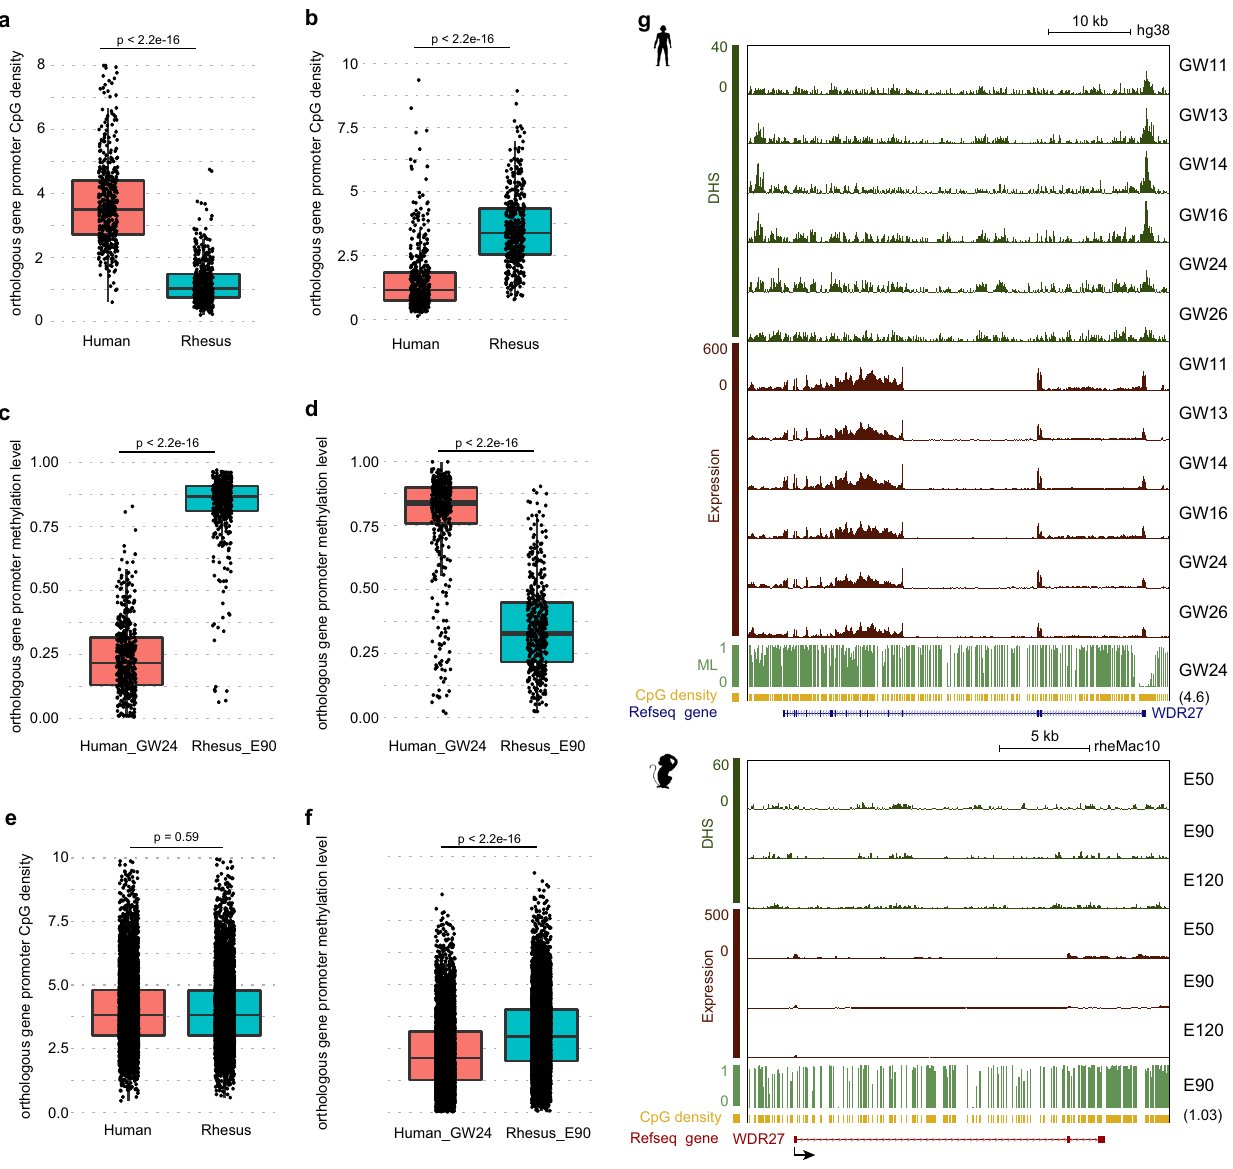
Fig. 5 The association between CpG densities and species-speci fi c DHSs. a Box and jitter plots comparing promoter CpG densities of orthologous genes, whose promoters are speci fi cally open in the human PFC ( n = 470 genes). Boxes and whiskers represent the 25th/75th percentiles and 1.5 ´ the interquartile range, respectively. The center in the boxplot represents the medium value. Student ’ s t test with a two-sided model was used in this fi gure. b Box and jitter plots comparing promoter CpG densities of orthologous genes, whose promoters are speci fi cally open in rhesus PFC ( n = 430 genes). Boxes and whiskers represent the 25th/75th percentiles and 1.5 ´ the interquartile range, respectively. The center in the boxplot represents the medium value. Student ’ s t test with a two-sided model was used in this fi gure. c Box plots showing DNA methylation levels of orthologous genes, whose promoters are speci fi cally open in humans ( n = 470 genes), at the human GW24 stage and the E90 stage in rhesus monkeys, respectively. Boxes and whiskers represent the 25th/75th percentiles and 1.5 ´ the interquartile range, respectively. The center in the boxplot represents medium value. Student ’ s t test with a two-sided model was used in this fi gure. d Box plots showing DNA methylation levels of orthologous genes, whose promoters are speci fi cally open in rhesus ( n = 430 genes), at rhesus E90 stage and human GW24 stage, respectively. Boxes and whiskers represent the 25th/75th percentiles and 1.5 ´ the interquartile range, respectively. The center in the boxplot represents the medium value. Student ’ s t test with two-sided model was used in this fi gure. e Box plots comparing promoter CpG densities of orthologous genes whose promoters are open in both human and rhesus ( n = 6683 genes) PFC. Boxes and whiskers represent the 25th/75th percentiles and 1.5 ´ the interquartile range, respectively. The center in the boxplot represents the medium value. Student ’ s t test with a two-sided model was used in this fi gure. f Box plots showing DNA methylation levels of orthologous genes whose promoters are conserved open in humans and rhesus monkeys ( n = 6683 genes), at human GW24 stage and rhesus E90 stage, respectively. Boxes and whiskers represent the 25th/75th percentiles and 1.5 ´ the interquartile range, respectively. The center in the boxplot represents the medium value. Student ’ s t test with a two-sided model was used in this fi gure. g Genome browser view of promoter DHS, RNA expression, DNA methylation level (ML) and CpG density of WDR27 in humans (top) and rhesus monkeys (bottom). The number in parenthesis indicates the promoter CpG density per 100 bp.